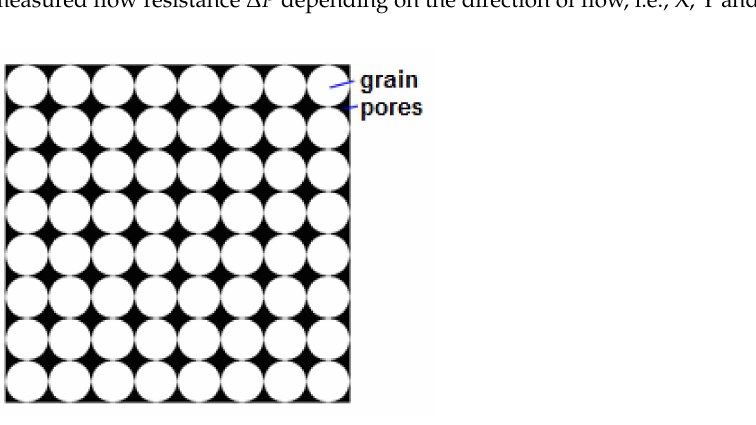
Figure 4. Research material—porous sinter: example of a porous material structure (black = free space; white = frame-based